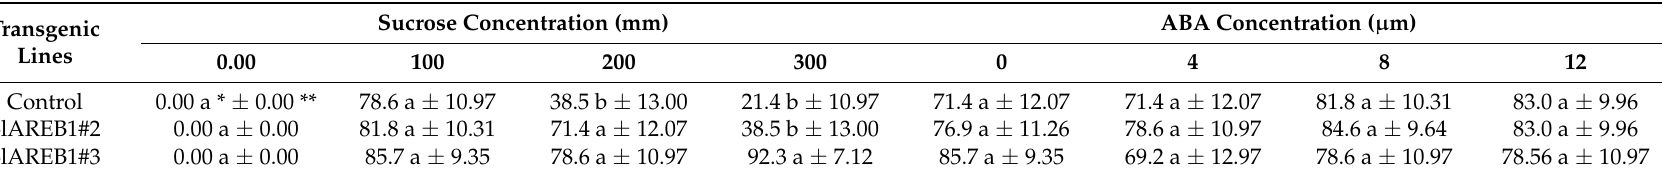
Table 2. Regrowth percentages of in vitro conserved microshoots of negative control, SlAREB1#2, SlAREB1#3 transgenic tomato plants after 12 weeks from culturing on media with different levels of sucrose and abscisic acid